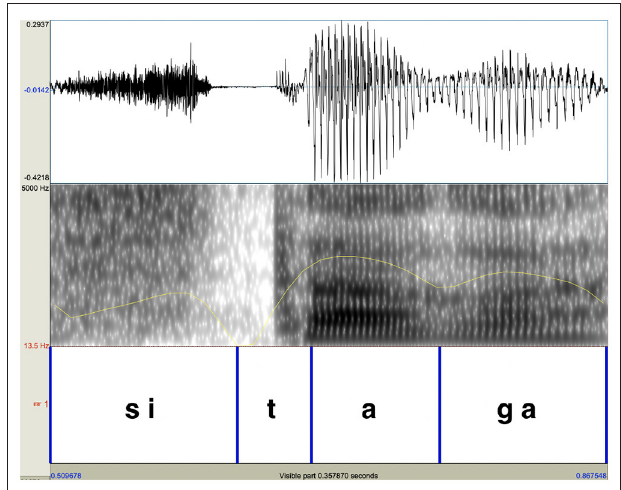
FIGURE 8 | Segmental boundaries were placed using the original natural speech. The duration of the word-final vowel of the word /sit´a/ was calculated by dividing the vowel duration by the word-final syllable